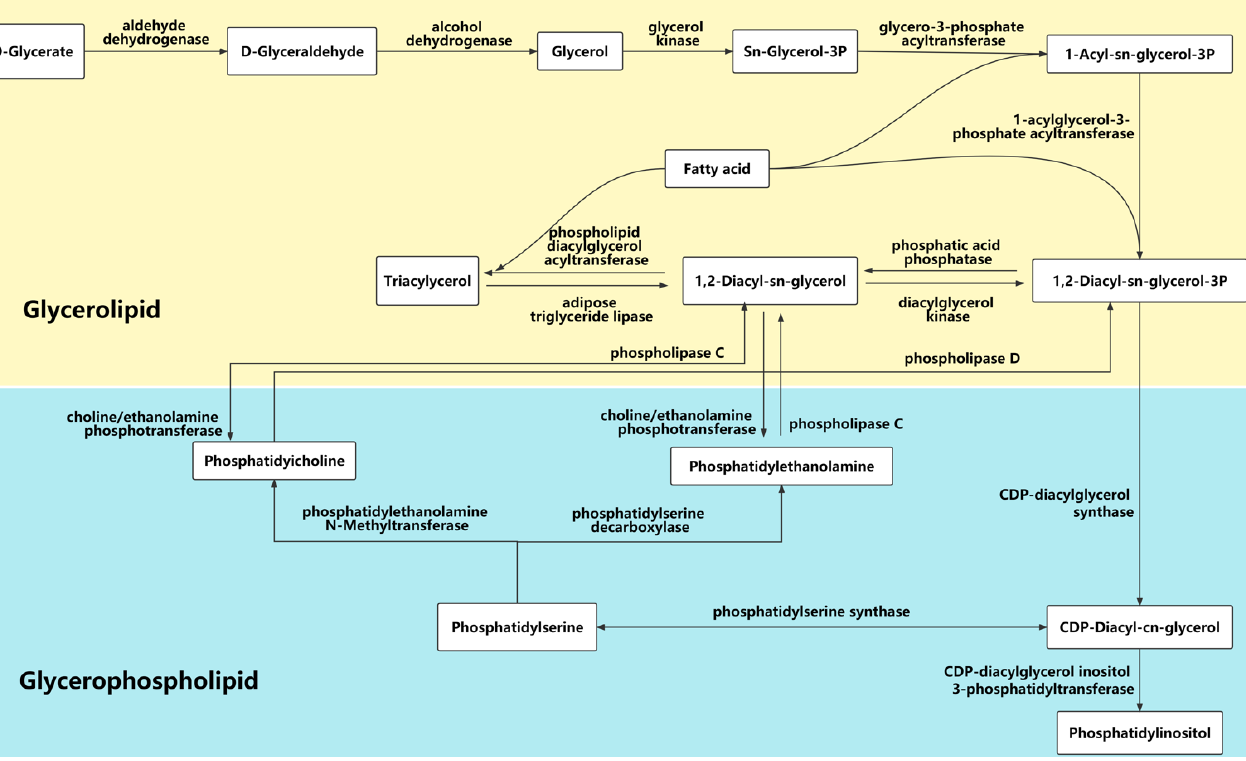
Figure 12. Metabolic pathways of glycerolipids and glycerophospholipids.